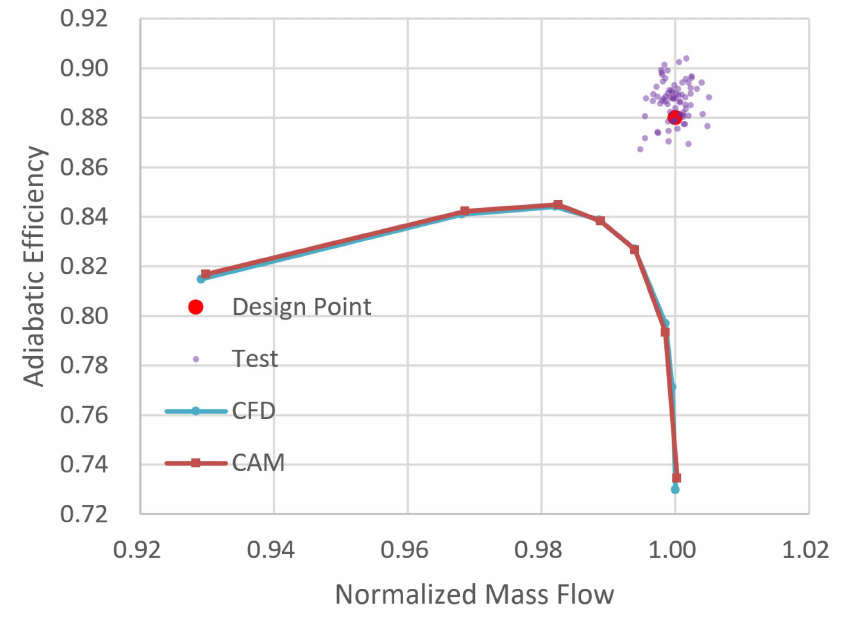
Figure 12. Adiabatic efficiency vs. inlet normalized